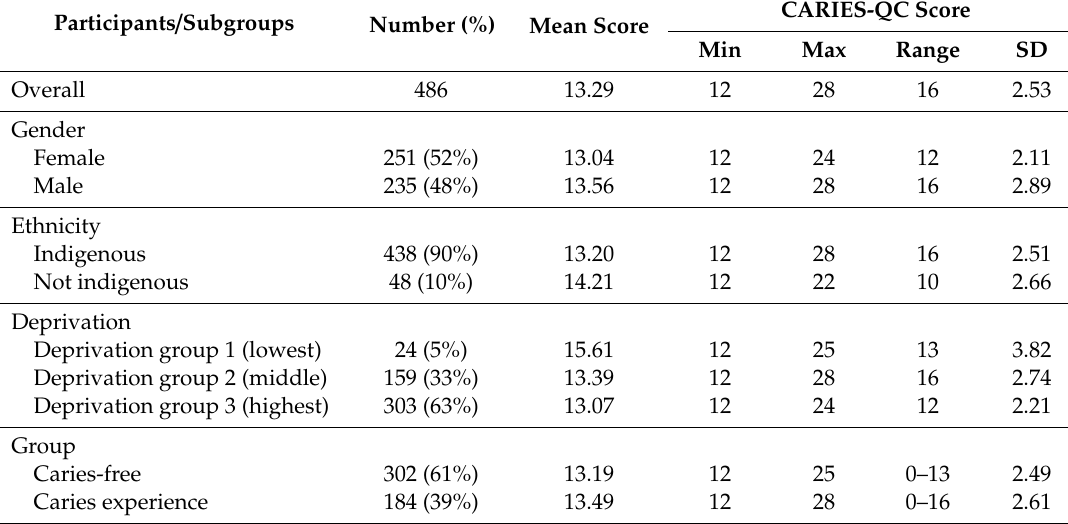
Table 4. CARIES-QC data by